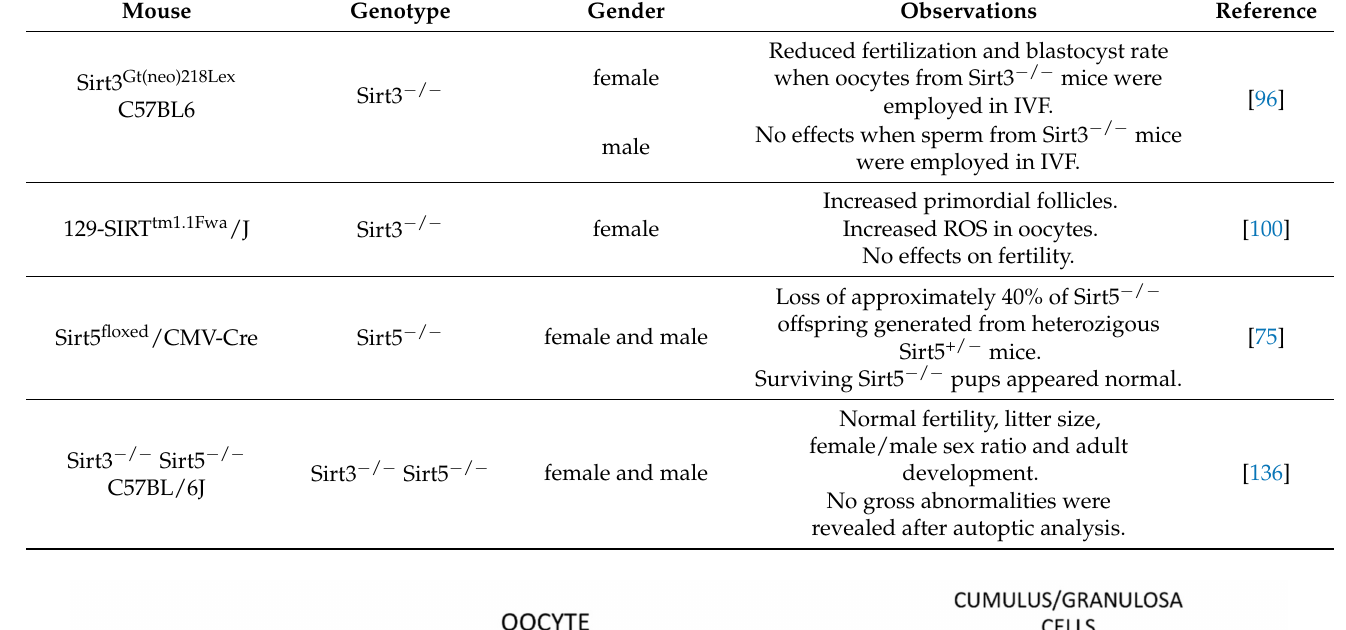
Table 1. Impact of mtSIRT knockout on fertility potential and offspring health.